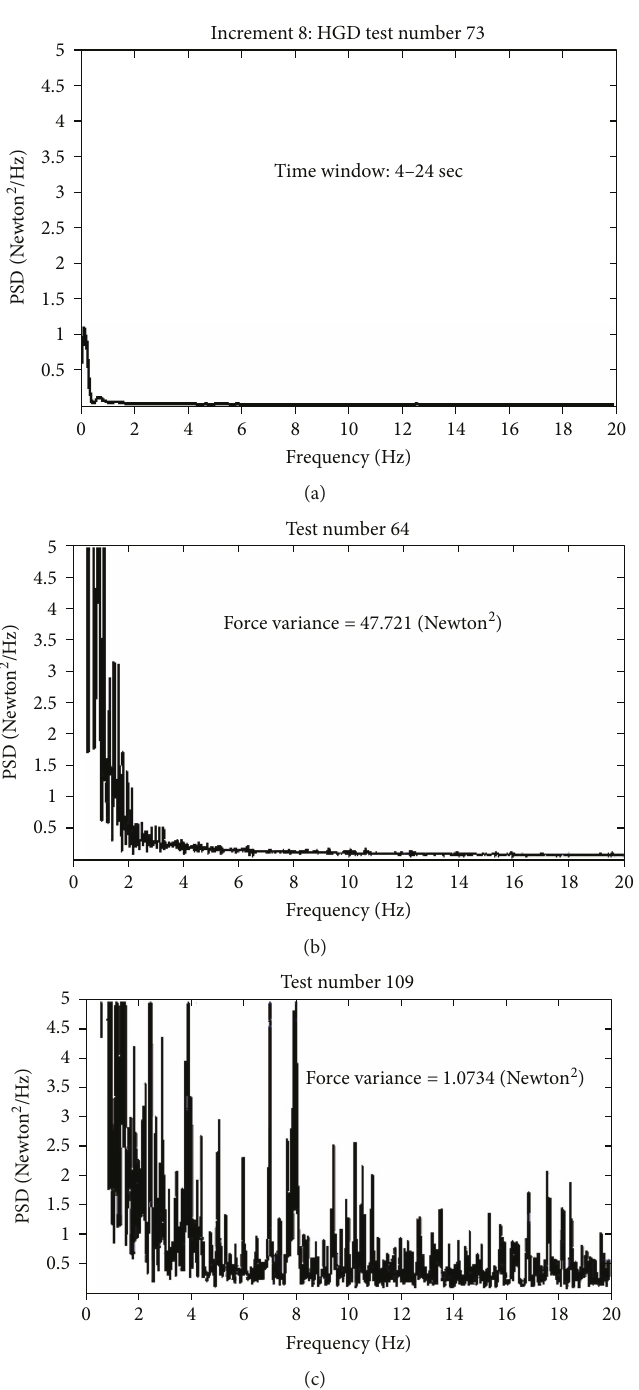
Figure 7: HGD power spectral density (PSD). (a) HGD-PSD for 0 – 20 Hz frequency window. (b) Test session 64. HGD-PSD 4 – 20 Hz frequency window. (c) Test session 109. HGD power spectral density (PSD) 4 – 20Hz frequency window. Data acquired at 25%